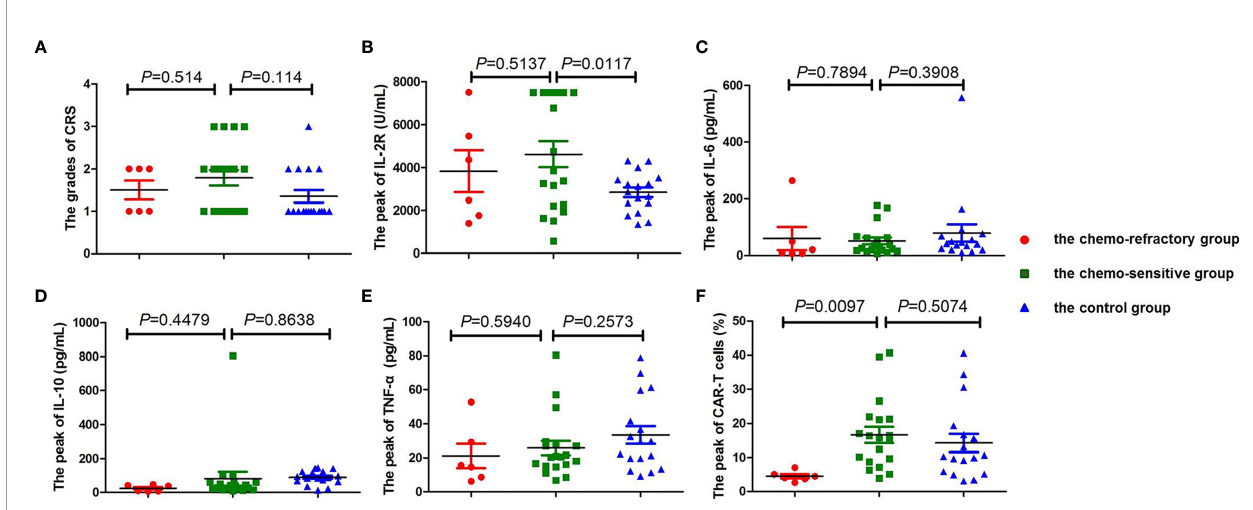
FIGURE 4 | Comparison of CRS, cytokine levels, and the peak of CAR-T cells between the chemo-sensitive, chemo-refractory, and control groups. No signi fi cant differences were found in CRS ( A , P = 0.514), IL-2R ( B , P = 0.5137), IL-6 ( C , P = 0.7894), IL-10 ( D , P = 0.4479), and TNF- a ( E , P =0.5940) between the chemo- sensitive and chemo-refractory groups, whereas statistical differences were observed in the peak of CAR-T cells between the two groups ( F , P = 0.0417). No signi fi cant differences were found in CRS ( A , P = 0.114), IL-6 ( C , P = 0.3908), IL-10 ( D , P = 0.8638), TNF- a ( E , P = 0.2573), and the peak of CAR-T cells ( F , P = 0.5074) between the chemo-sensitive and control groups, whereas statistical differences were observed in IL-2R between the two groups ( B , P = 0.0117). CRS was compared by Mann – Whitney rank. Unpaired Student ’ s t-test was used to compare the cytokine levels and the peak of CAR-T cells.